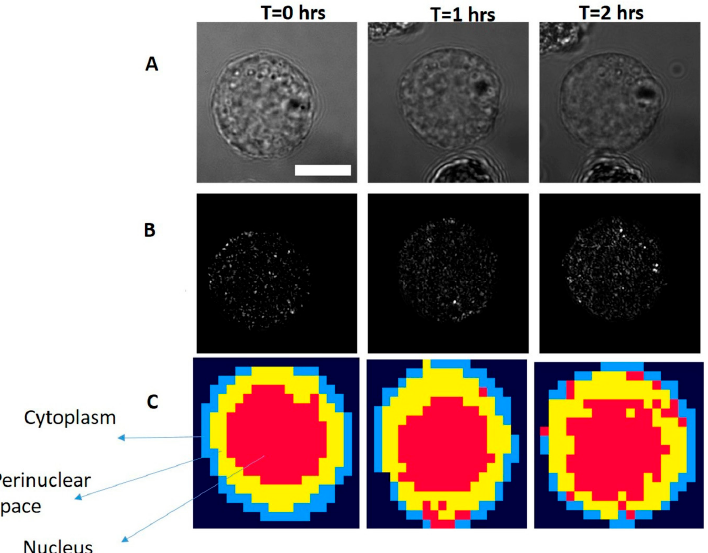
Figure 2. Temporal monitoring of the same RPMI8226 cell after applying 50 nM Bortezomib at time zero (Scale bar: 5 µm): ( A ) bright field image; ( B ) confocal reflectance (binary mask is applied to target cell to eliminate the effect from outside of the cell); and ( C ) Four cluster Raman images. Different intracellular regions are marked.